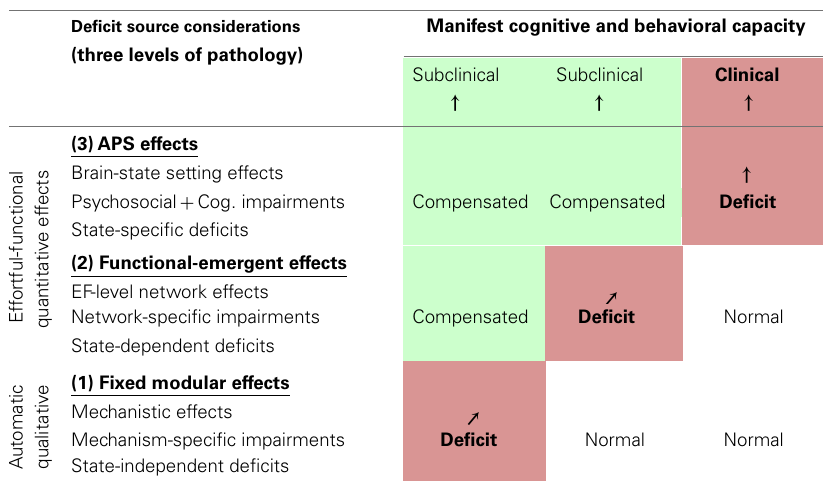
Table 1 | Multi-level deficit analysis schema for dimensionally defined disorders